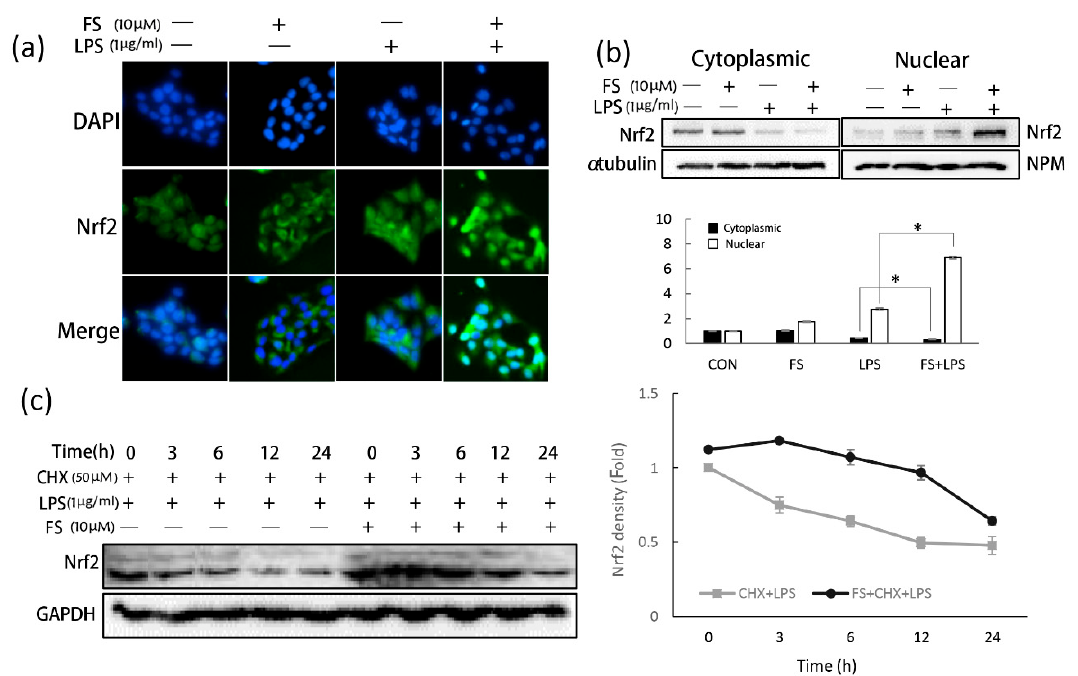
Figure 5. The effects of FS on Nrf2 translocation and stability. ( a ) In order to confirm the translocation of Nrf2, the immunofluorescence staining was used to observe Nrf2 location via green fluorescence. 4‘,6-diamidino-2-2phenylindole (DAPI) was used to show the location of nucleus via blue fluorescence. ( b ) Nuclear Nrf2 (nuclear factor erythroid 2-related factor 2) levels in HaCaT cells were measured with Western blotting. ( c ) 50 µM cycloheximide (CHX) was used to block the synthesis of Nrf2 in HaCaT cells to evaluate the effect of FS on Nrf2 stability. * p -value < 0.05.